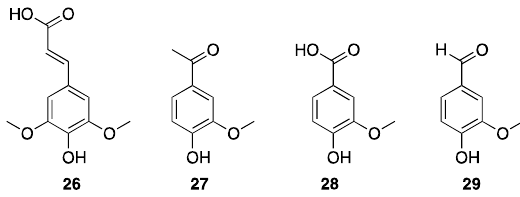
Figure 4. Lignin depolymerization products.